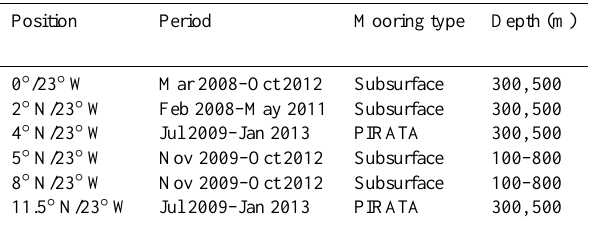
Table 2. Moored oxygen observations in the eastern tropical At- lantic along 23 ◦ W.